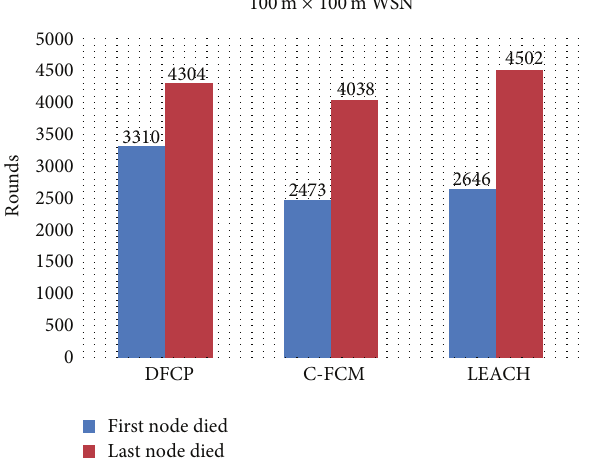
Figure 7: The first and last node die comparison for 100m × 100 m area network.